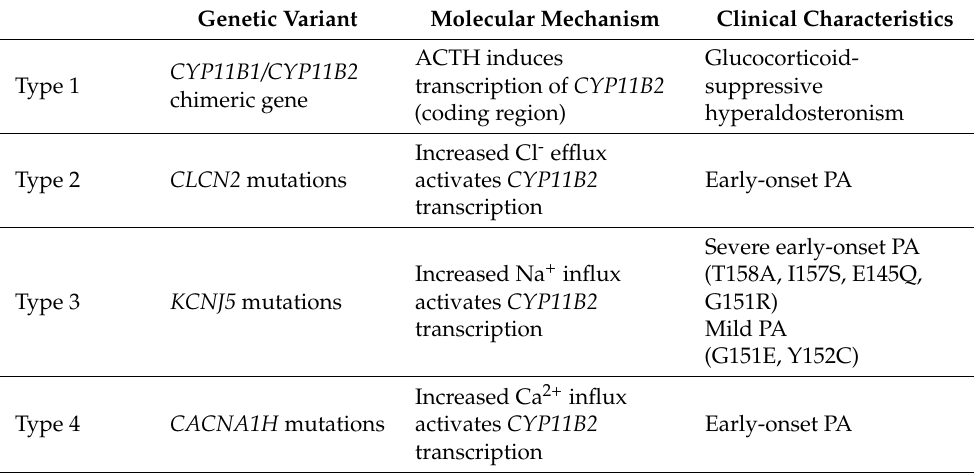
Table 2. Clinical and molecular characteristics of familial hyperaldosteronism (FH). Genetic Variant Molecular Mechanism Clinical